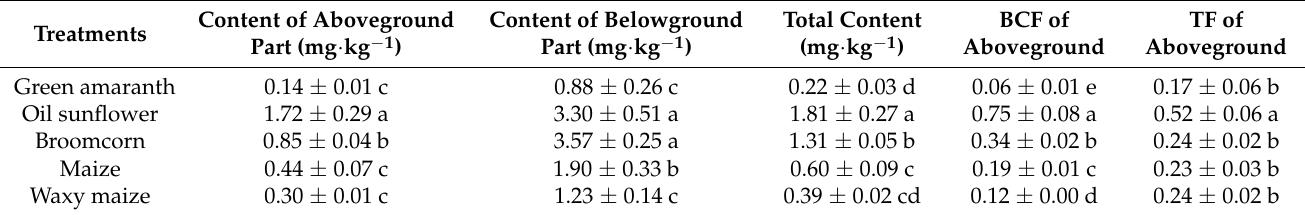
Table 4. Cd-enrichment characteristics of aboveground- and belowground-parts of plants.